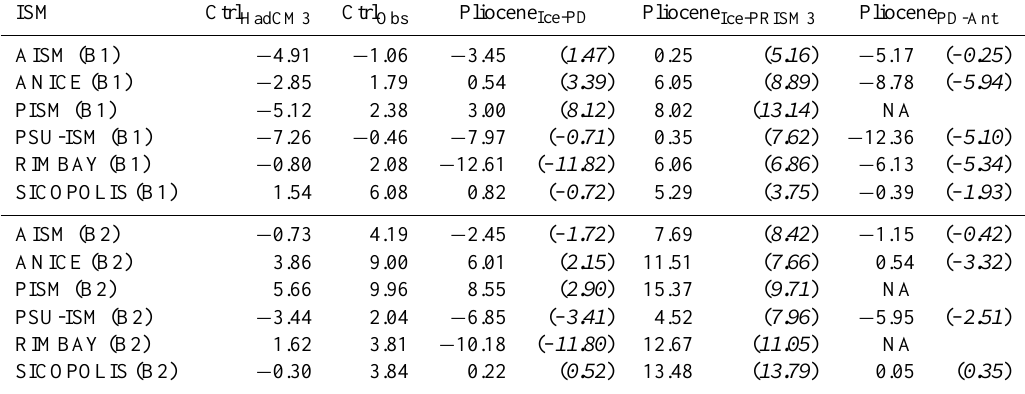
Table 4. Contribution to the mean sea level (m) for all simulations relative to the initial PD ice sheet using Bedmap1 (B1) and Bedmap2 (B2). Contributions are calculated with a constant ocean area of 3.62 × 10 14 m 2 using only grounded ice above flotation and corrected for changes in bedrock elevation (see text for details). Differences for the three Pliocene experiments with Control HadCM3 are shown in brackets. ISM Ctrl HadCM3 Ctrl Obs Pliocene Ice-PD Pliocene